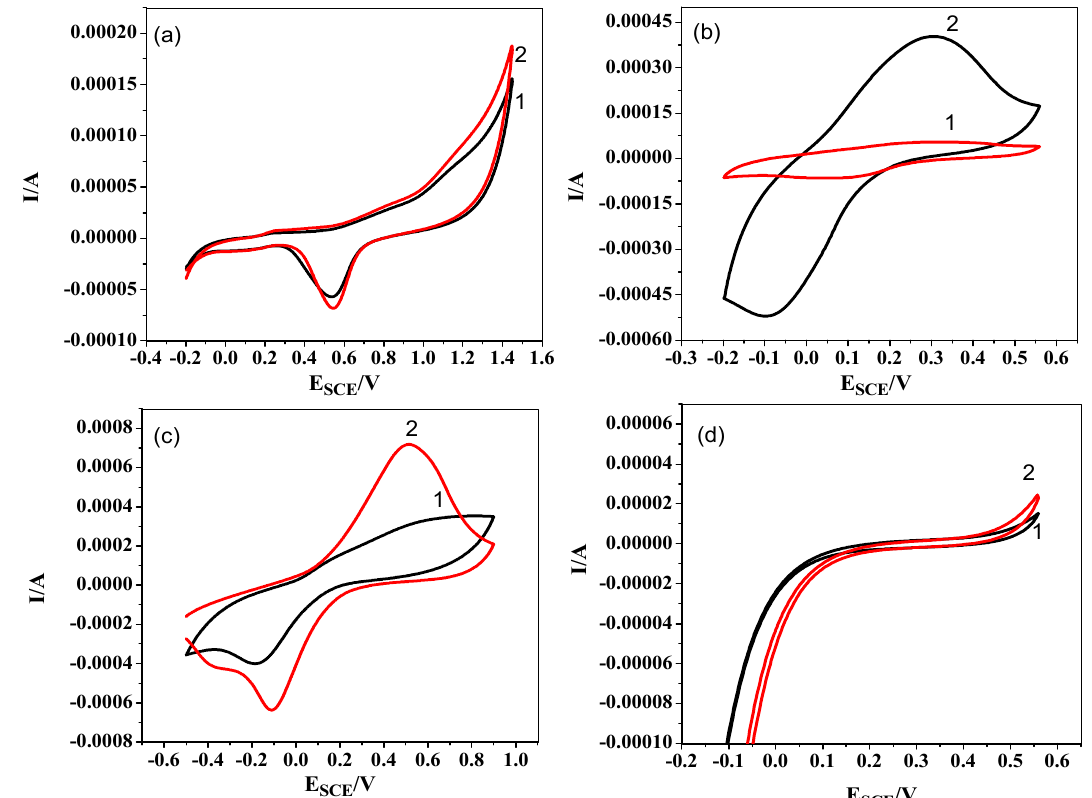
Figure 1. Cyclic voltammetry (CV) of ( a ) bare gold, ( b ) poly(aniline-co-2-hydroxyaniline) (PACHA)-, ( c ) polyaniline (PANI)-, and ( d ) poly (2-hydroxyanilne) (PHA)-coated electrodes in a citrate buffer of pH 5, without (1) and with (2) 1.4 × 10 − 6 M H 2 O 2 .